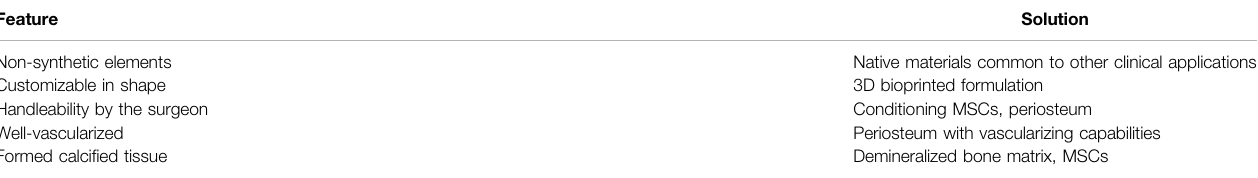
TABLE 1 | Requirements of bespoke bone